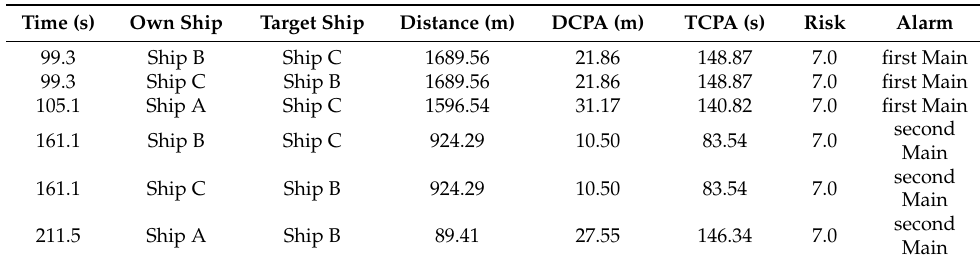
Table 3. Analysis of the situation when the first alarm was generated on each ship from the test results of Scenario